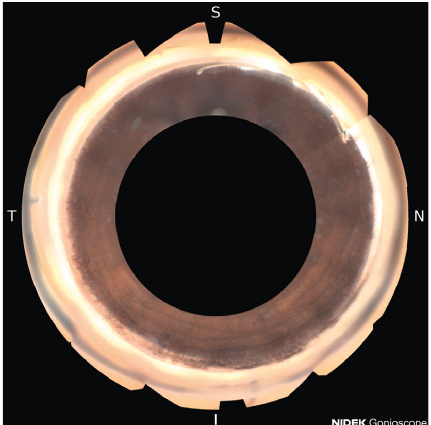
Figure 1: Extrusion of the distal tip of the Hydrus stent from Schlemm’s canal.